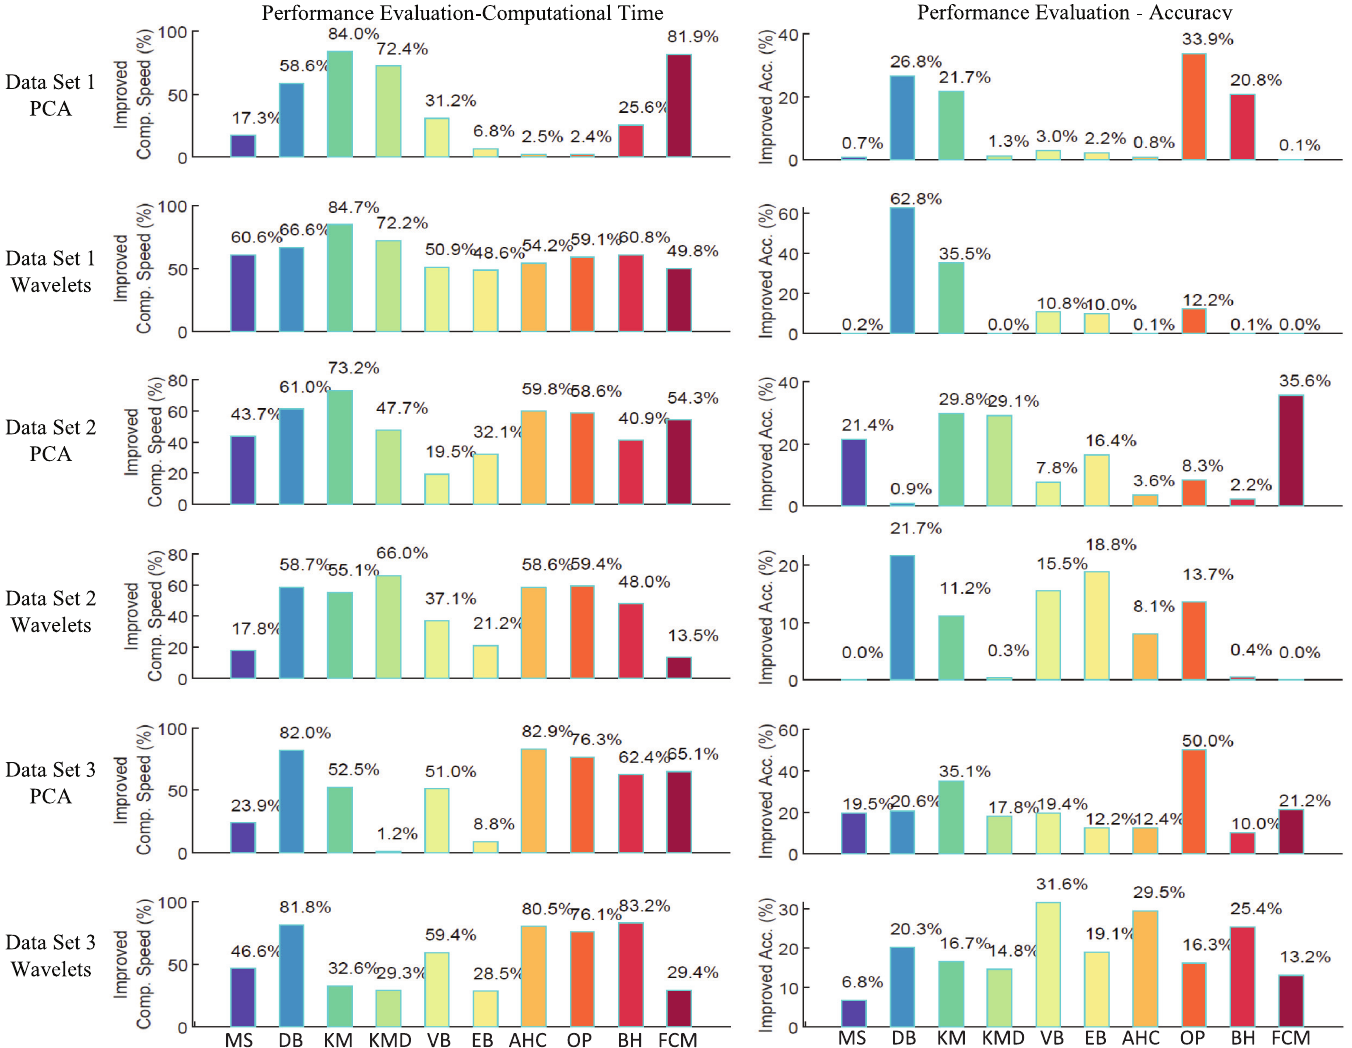
Fig 7. Illustration of improved computational speed and clustering accuracy. (a) Improved computational speed in percentage of understudy ten algorithms across six large neural feature sets. (b) Improved clustering accuracy in percentage of understudy ten algorithms across six large neural feature sets. The proposed data-subdivision and unification method has shown a positive trend in improving the performance of spike sorting algorithms. The improvement in reducing computational time is significantly high, while due to maturity of spike of sorting algorithms, accuracy improvement is relatively lower in some of spike sorting algorithms. The average results for 10 repetitive analysis has been presented and it is worth noting that proposed mechanism has shown promising improvement results around all data types and spike sorting algorithms.